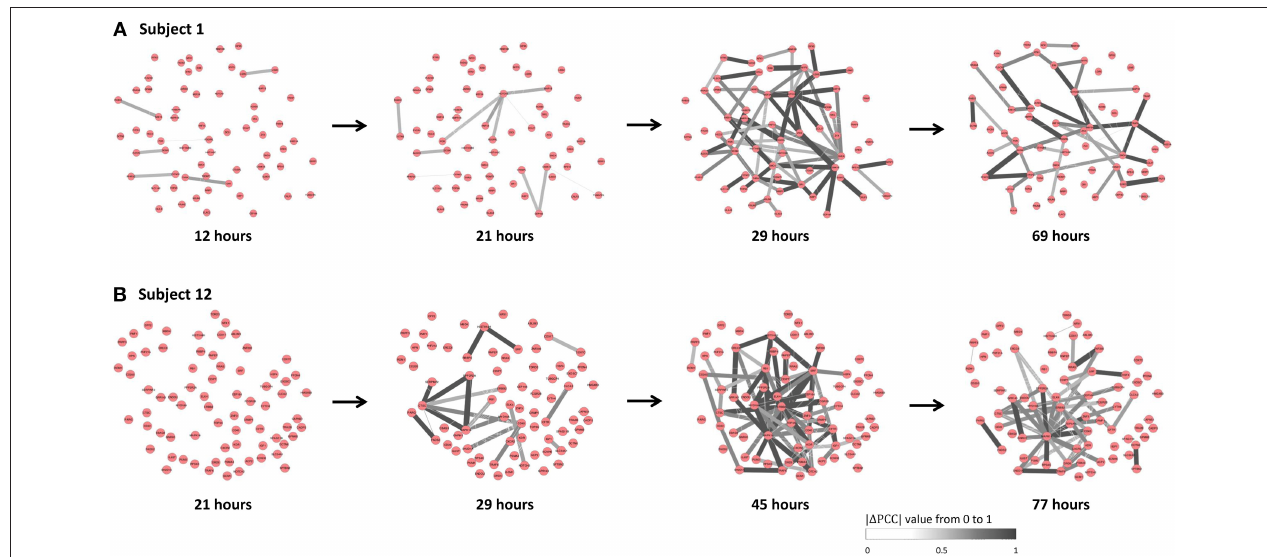
FIGURE 6 | The dynamical evolution of subject-specific networks. To illustrate the dynamical evolution of the differential network, the individual-specific networks of two symptomatic subjects (subjects 1 and 12) were exhibited. (A) The individual-specific networks for subject 1. (B) The individual-specific networks for subject 12. Clearly, at the identified tipping point of each subject, there were considerably more differential edges than that at other time